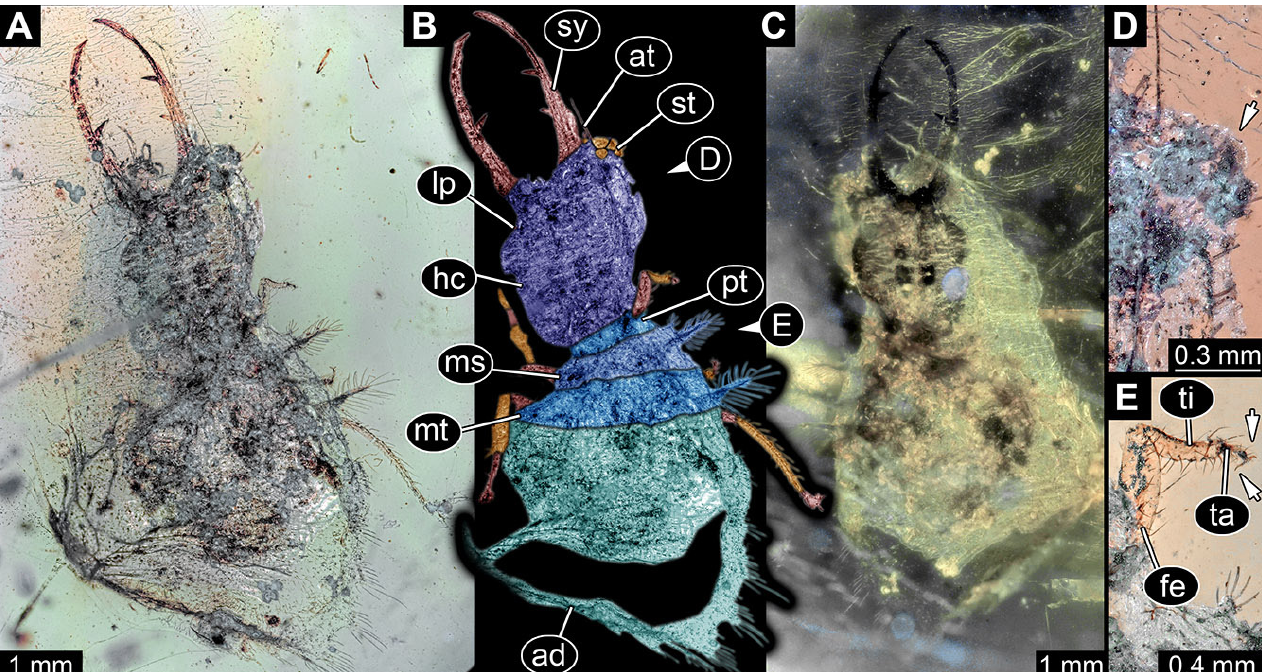
Figure 31. Fossil owllion larva, specimen 3244 (PED 0684), Cretaceous Kachin amber, Myanmar. ( A ) Overview, dorsal. ( B ) Color-marked version of ( A ). ( C ) Overview, ventral. ( D ) Close-up on head capsule with field of stemmata (arrow). ( E ) Close-up on locomotory appendage with claws (arrows). Abbreviations: ad = abdomen; at = antenna; fe = femur; hc = head capsule; lp = labial palp; ms = mesothorax; mt = metathorax; pt = prothorax; st = stemmata; sy = stylet; ta = tarsus; ti = tibia.